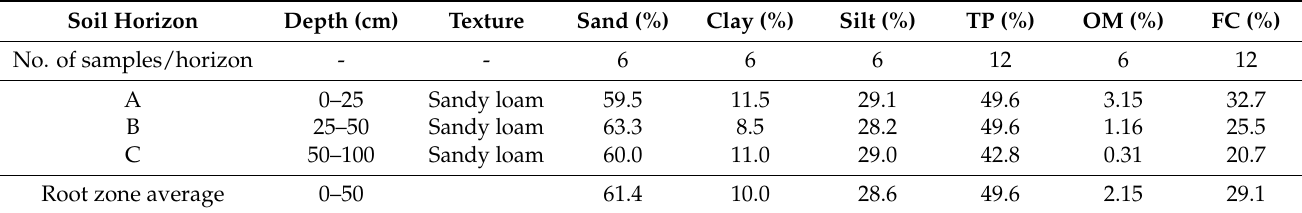
Table 1. Soil properties at the study site 1